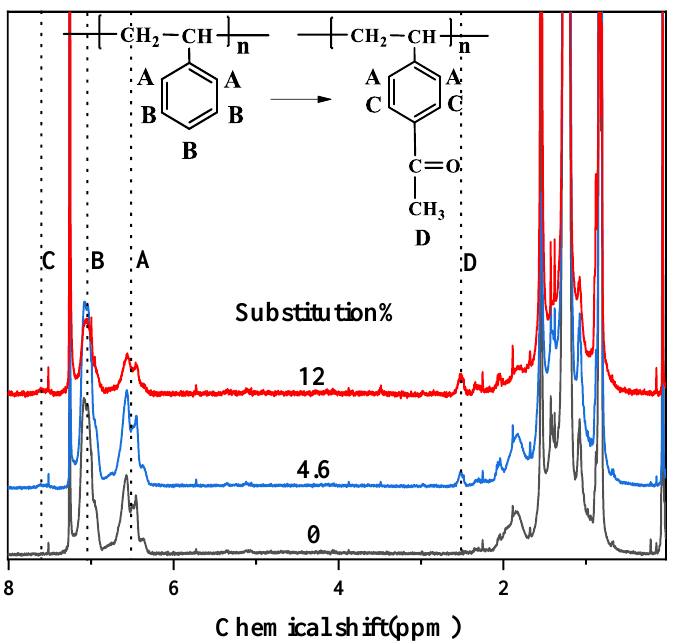
Figure 3. 1 H NMR spectrum of SEBS and Ac-SEBS.